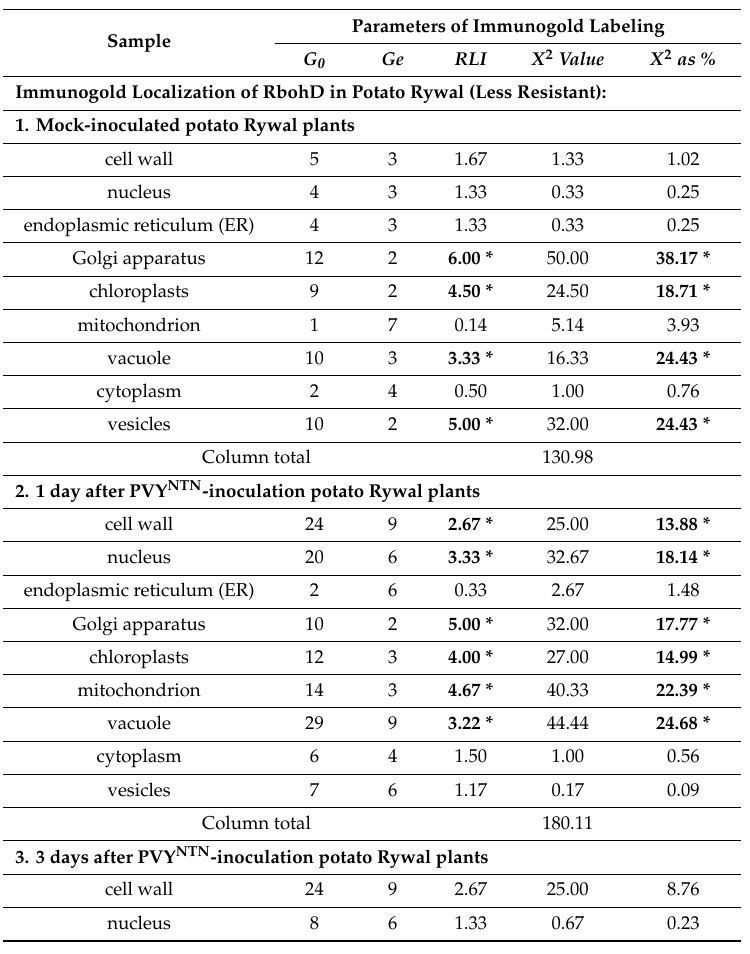
Table 2. Quantification of immunogold labeling of RbohD by RLI and X 2 tests in mock-inoculated and PVY NTN -inoculated Rywal (less resistant) potato plants before HR symptoms (1 dai) and after HR symptoms developed (3 dai). Significant values (RLI > 1, and % X 2 at least 10%) are in bold font and marked with an